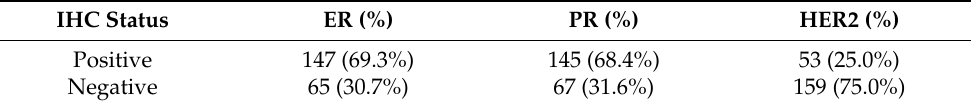
Table 3. Distribution of immunohistochemical studies in BC patients.